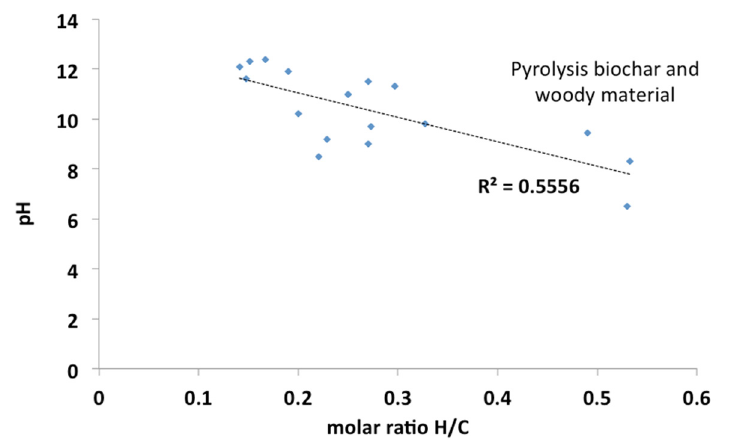
Figure 14. Measured pH of the biochar samples vs. carbonization